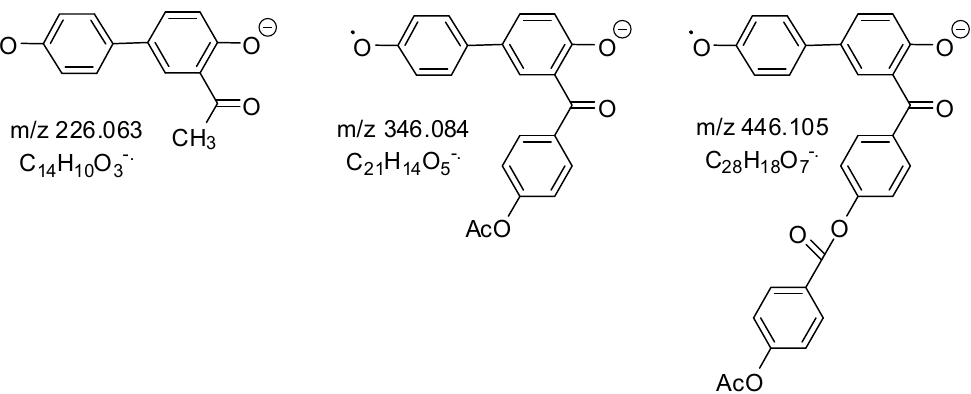
Figure 3. Fries rearrangement products in mass spectra.